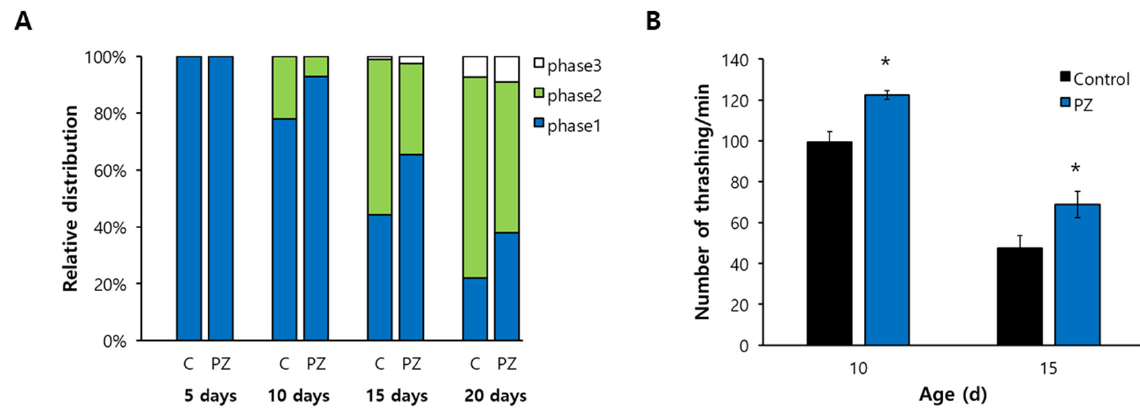
Figure 3. Delayed muscular dysfunction with age by supplementation with phlorizin. ( A ) Locomotive activity was classified into three phases according to motility of each worm (n = 100). ( B ) Number of thrashings was counted for 1 min for 10- and 15-day-old worms under microscope (n = 15). Error bar indicates standard error. C, untreated control; PZ, phlorizin (10 μ M); *, a significant difference ( p < 0.05) compared to untreated control.